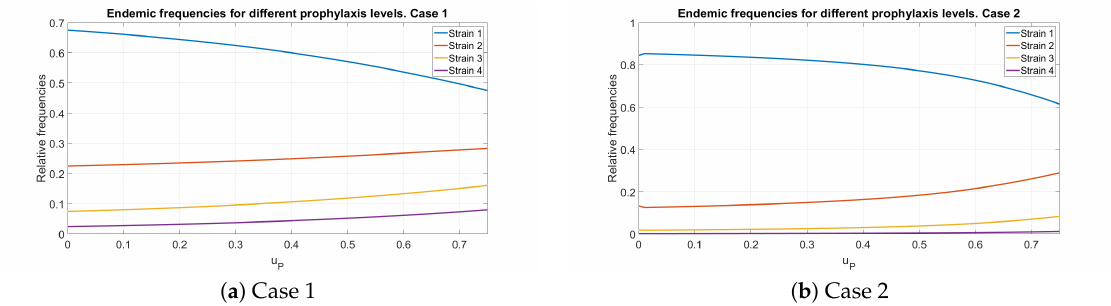
Figure 3. The relative endemic distribution of infected individuals for different values of u P . Subfigures ( a ) and ( b ) correspond to different values of mutation probabilities π i .